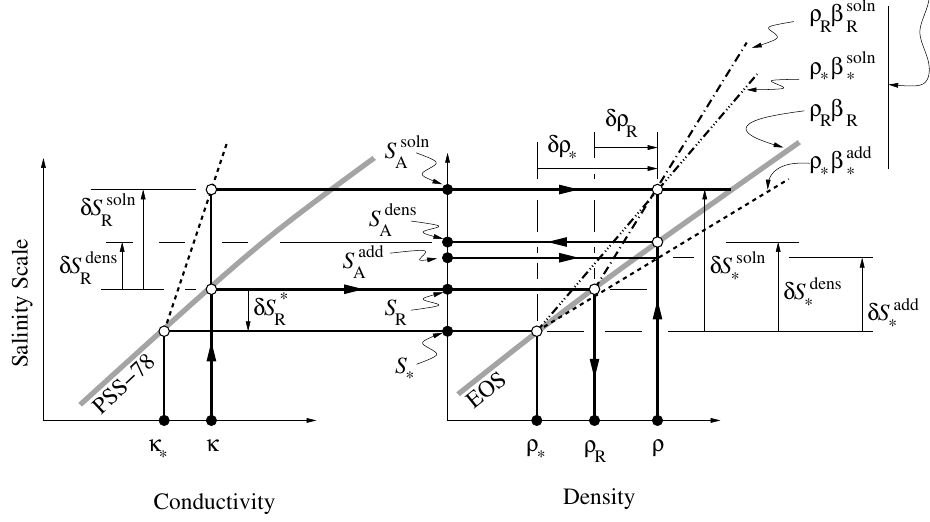
Fig. 1. Schematic illustrating the relationships between different salinities, densities, and conductivities used in the text. The conductiv- ity/salinity relationship is on the left side with the scaled PSS-78 relationship shown as a gray curve. The density/salinity relationship on the right side, with the equation of state (EOS) for SSW shown as a gray curve. Salinity measures are common to both relationships. Salinities are indicated by subscripts for preformed (*), reference (R) and absolute (A) salinities, with further differentiations of the latter using su- perscripts for added salinity (add), density salinity (dens) and true or solution absolute salinity (soln). The notational convention for salinity . For further information see Sect. 2.3 and Table variations is S to = S from + δS to from